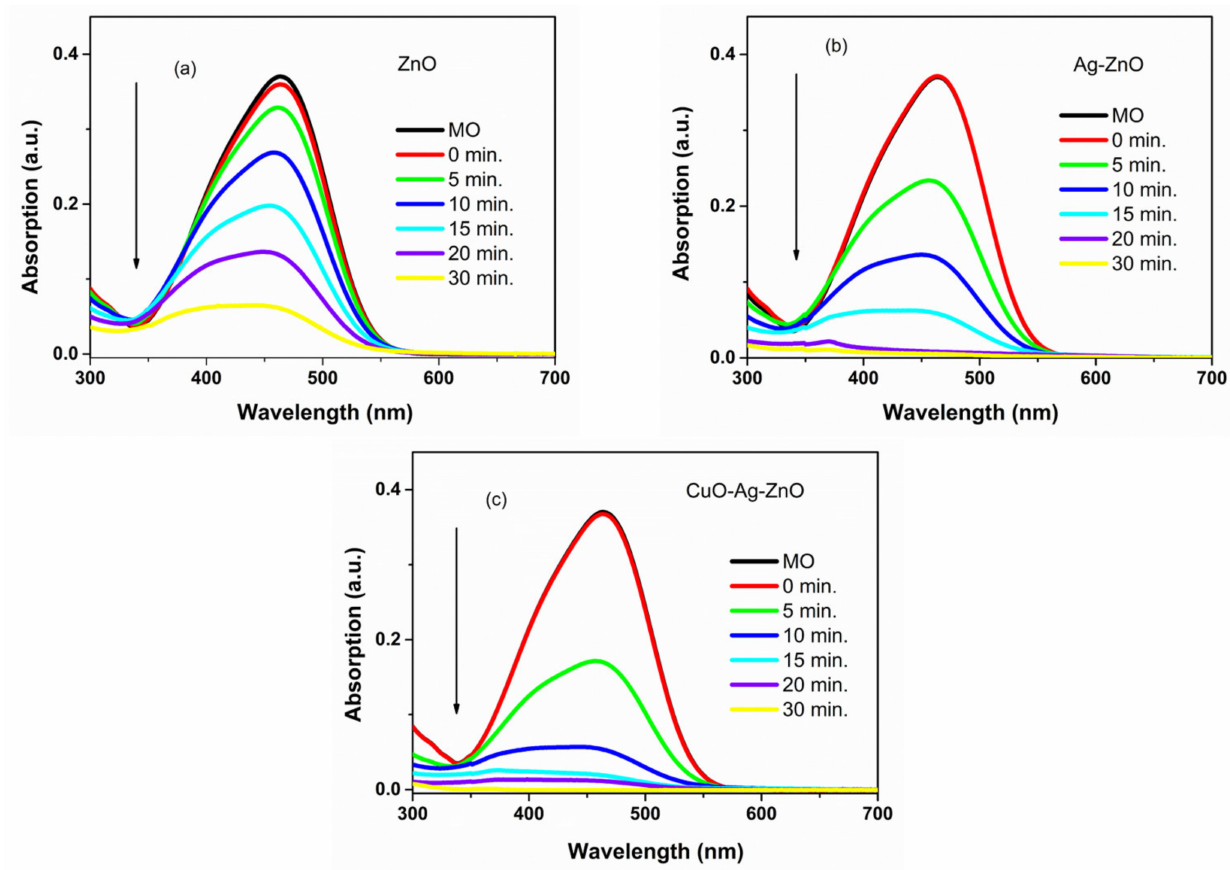
Figure 9. UV–vis absorption spectra of ZnO ( a ), Ag-ZnO ( b ), and CuO-Ag-ZnO ( c ) for degradation of MO under irradiation of solar simulator light by the as-prepared samples.